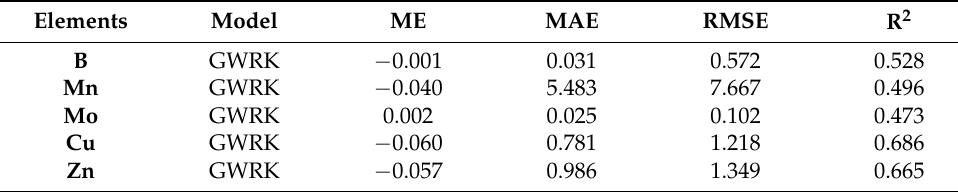
Table 5. Precision evaluation index of soil trace elements prediction model.